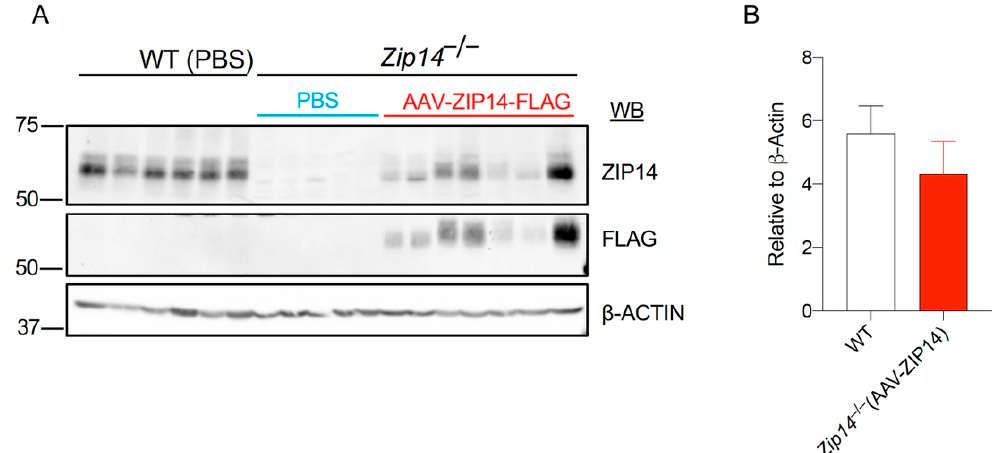
Figure 4. Adeno-associated virus (AAV)-mediated hepatic ZIP14 expression in Zip14 − / − mice. Zip14 − / − mice received a single dose of ZIP14-expressing AAV (AAV-ZIP14-FLAG) via intraperitoneal injection at 1 week old. At 3 weeks of age, mice were sacrificed and tissue samples were collected. PBS was used as the vehicle control. ( A ) Liver samples were analyzed by Western blotting (WB). Blots were probed for ZIP14 using both anti-mouse ZIP14 and anti-FLAG antibodies. β -Actin was used as a loading control. ( B ) The relative expression levels of ZIP14 in PBS-injected WT mice and AAV-ZIP14-injected Zip14 − / − mice were determined by normalizing to β -ACTIN ( n = 5–7 female mice/group).